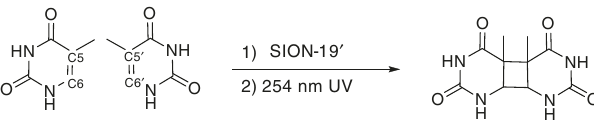
Fig. 5 Thymine photodimerization. Synthetic conditions utilized for the photodimerization of Thy molecules using SION-19